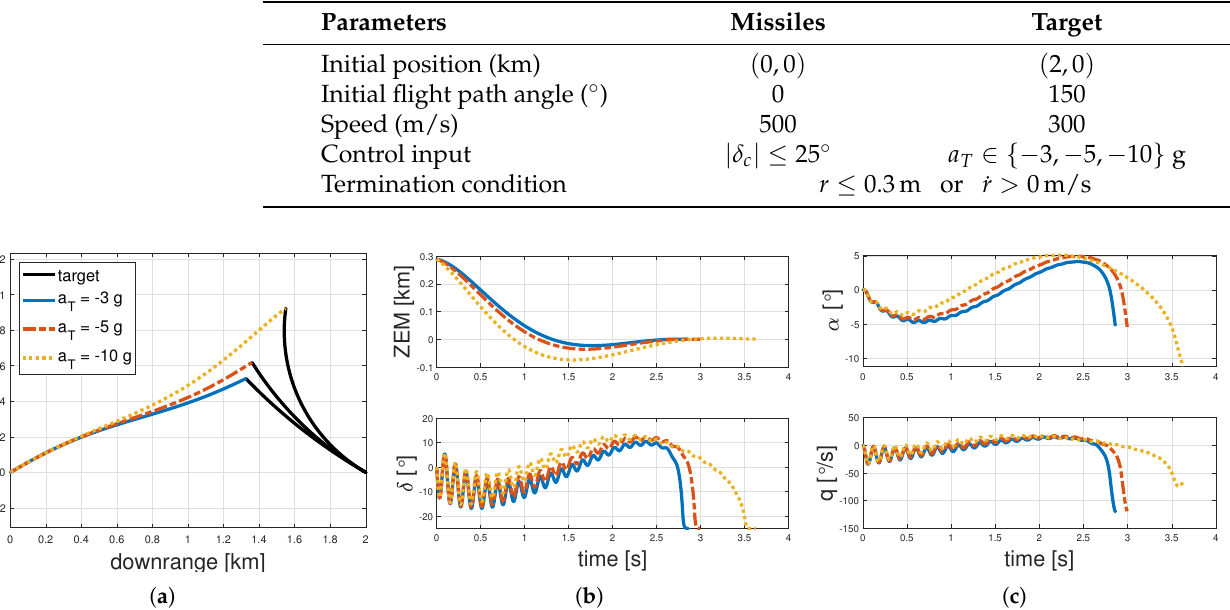
Figure 3. Simulation results of the separate method under the canard-controlled missile model. ( a ) Flight trajectories. ( b ) ZEM and fin deflections. ( c ) State variables.